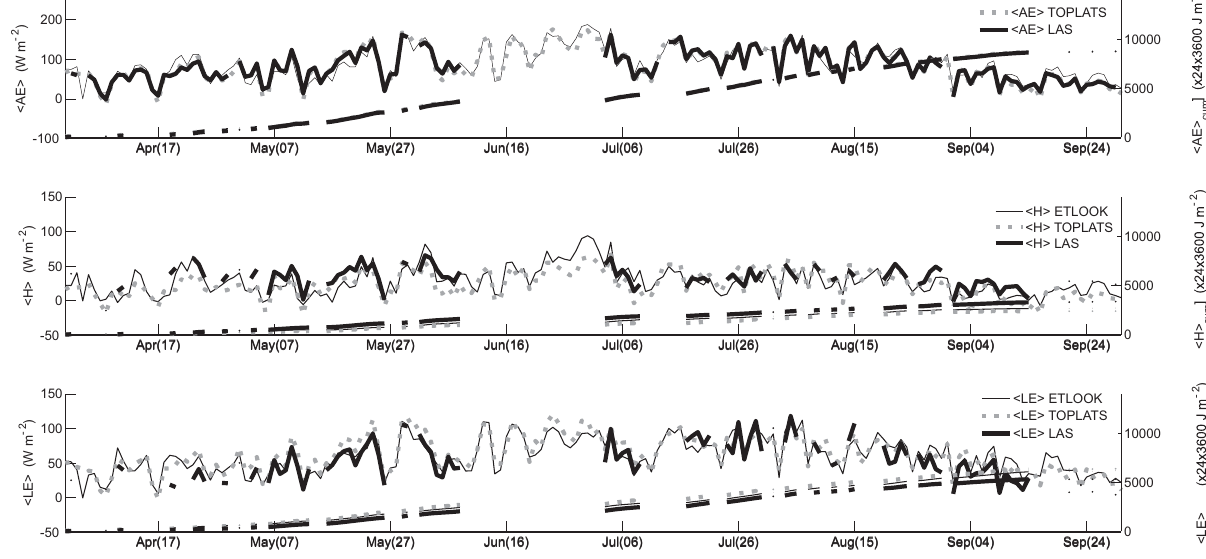
Fig. 5. Time series for daily < AE > (top panel), <H > (middle panel) and < LE > (bottom panel) as calculated by ETLook, TOPLATS and LAS for the Bellebeek catchment. Cumulative values for the available days are given as well (right axes).